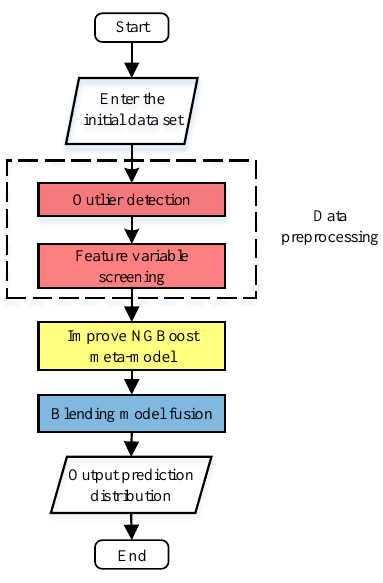
Figure 2. Overall flow chart.